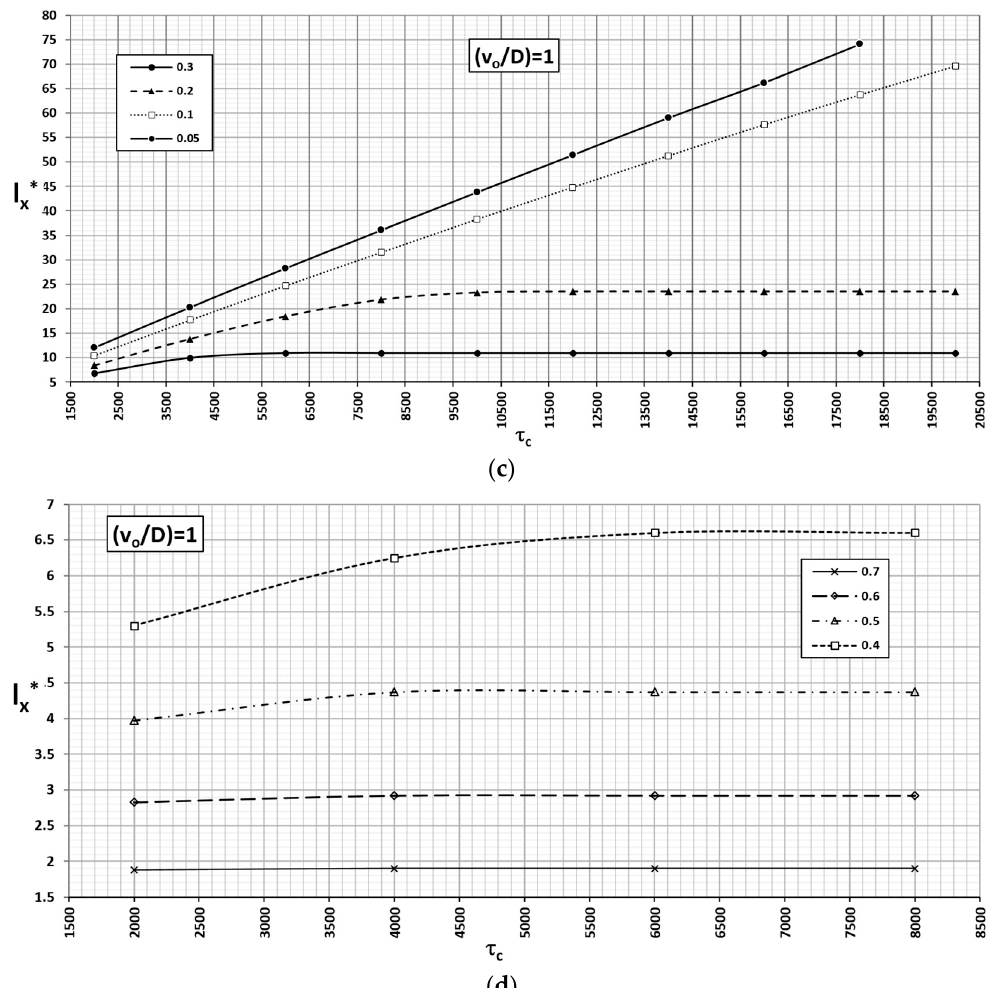
Figure 8. Universal curve l ∗ as a function of time factor τ c . Parameter of the abacus v o = 1, v o = 0.0006 m/d. ( a ) τ c ∈ [100–2000 days], ( b ) τ c ∈ [10–100 days], ( c ) τ c ∈ [2000–20,000 days], ( d ) τ c ∈ [2000–8000 days]. The abacus corresponding to the monomials = 2, 5 and 10 are shown in Figures (cid:2888) 9–11, respectively, with details similar to the previous ones. Numerical solutions have been obtained by retaining the regional velocity (v o = 0.0006 m/d) and changing the diffu- sivity to successive values D = 3·10 − 4 , 1.2·10 − 4 and 3·10 − 4 m 2 /d. In this way, the time factor is related to real time through the same expression as the former abacus (21).